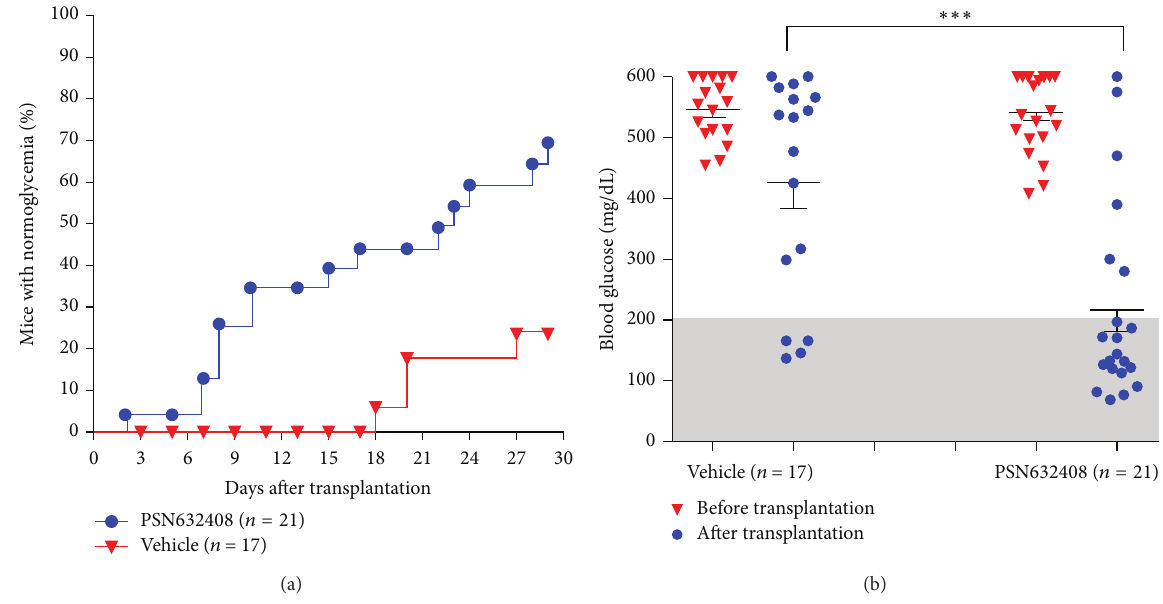
Figure 1: (a) Percentage of STZ-induced diabetic NOD.scid mice achieving normoglycaemia after human islet transplantation and 4 weeks of treatment with PSN632408 or vehicle. At 4 weeks after transplantation, percentage of mice with normoglycaemia was 71% in PSN632408- treated diabetic mice and 24% in vehicle-treated mice ( 𝑃 < 0.002 ). (b) Nonfasting blood glucose levels in PSN632408-treated mice and in vehicle-treated mice before transplantation and at 4 weeks after transplantation. PSN632408 treatment significantly reduced the mean nonfasting blood glucose level compared with vehicle treatment at 4 weeks after transplantation ( ∗∗∗ 𝑃 < 0.001 ).